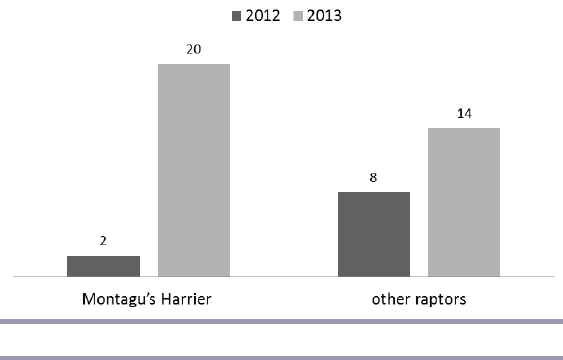
Fig. 1 . Number of observations of Montagu’s Harrier ( Circus pygargus ) and other raptors in the male Black- headed Bunting ( Emberiza melanocephala ) survival study plot (Dazlina, North Dalmatia, Croatia) during May and June 2012 and 2013.